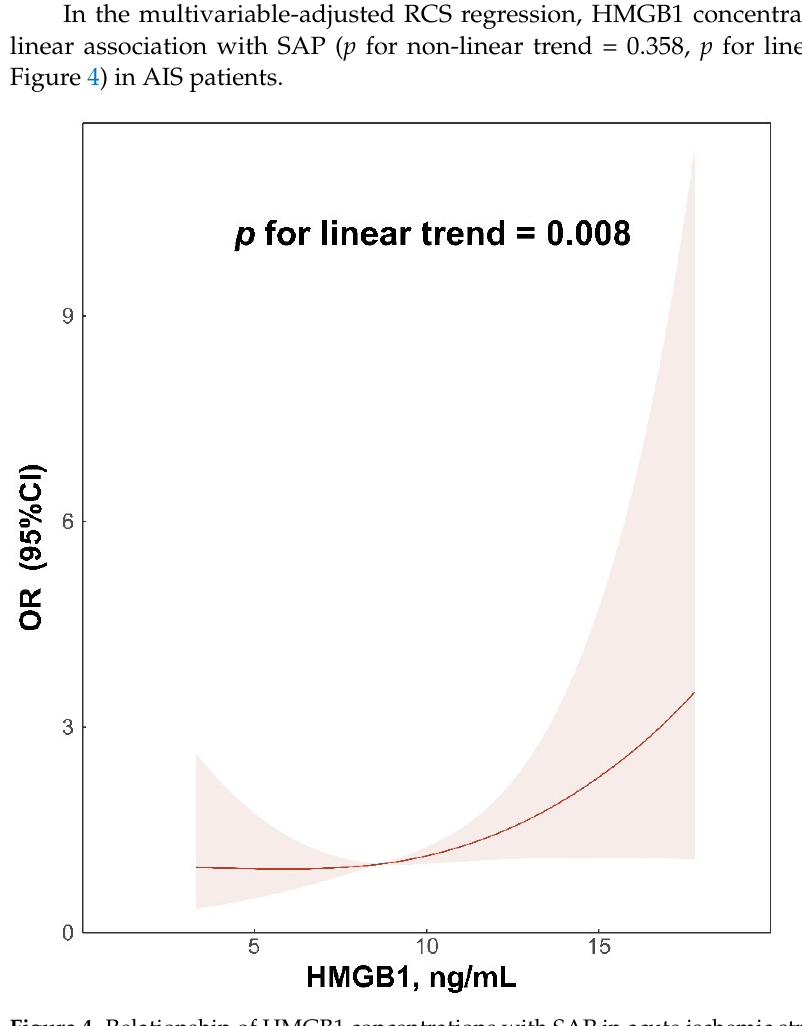
Figure 4. Relationship of HMGB1 concentrations with SAP in acute ischemic stroke patients. Odds ratios and 95% confidence intervals derived from restricted cubic spline regression, which was adjusted for age, sex, atrial fibrillation, coronary artery disease, previous stroke, NIHSS at admission, dysphagia at admission, ventilator during hospitalization, BMI, TOAST subtype, WBC, and FBG, with knots placed at the 5th, 50th, and 95th percentiles of the distribution of HMGB1 concentrations. HMGB1, high-mobility-group box 1; SAP, stroke-associated pneumonia; NIHSS, National Institute of Health Stroke Scale; BMI, body mass index; TOAST, Trial of Org 10172 in Acute Stroke Treatment; WBC, white blood cells; FBG, fasting blood glucose.